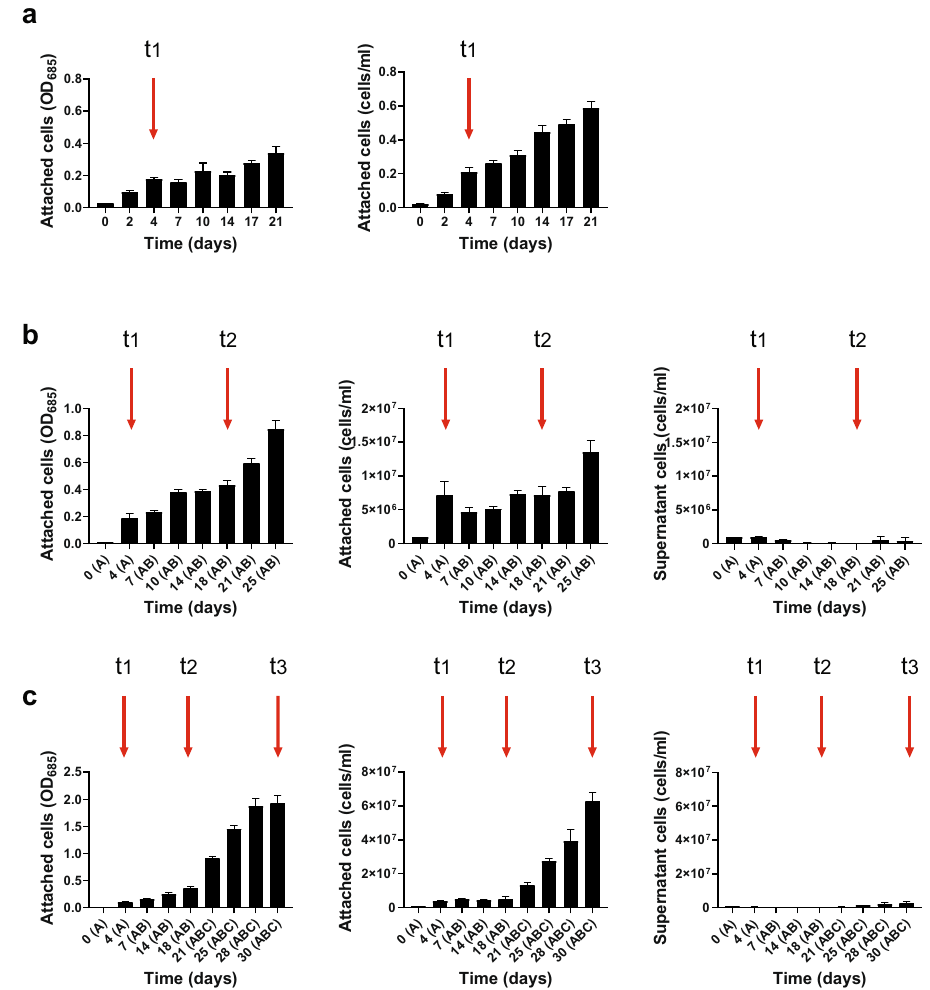
Fig. 2 Increase of the benthic biomass during periphyton establishment. The concentrations (mean ± s.d.; n = 3) of attached and non- attached cells (supernatant) were quanti fi ed via optical density (OD) at 685 nm and cell count with a CASY cell counter throughout the periphyton development; separately for the two species of group A ( a ), then for groups A and AB (upon addition of group B onto group A at 4 days of growth) ( b ) and for groups A, AB, and ABC (upon addition of group C onto group AB at 18 days of growth) ( c ). Red vertical arrows indicate selected time points when group B species were added on top of group A (t 1 ), group C on top of group AB (t 2 ), and periphyton was established (t 3 ). Cell concentrations in the supernatant for C. meneghiniana and A. pyrenaicum when grown separately ( a ) were below the quanti fi cation limit; hence no graphics for supernatant is